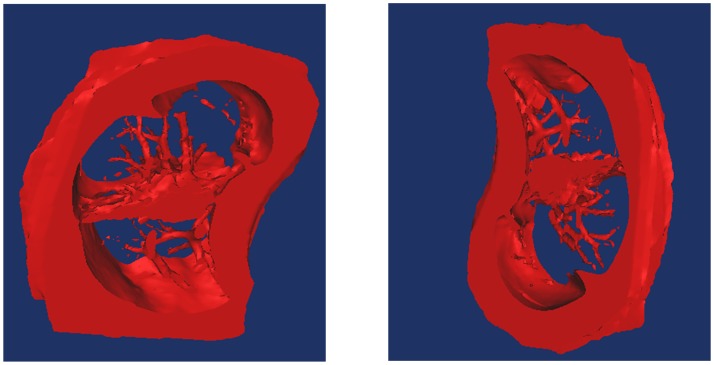
3D reconstruction of juxta-vascular nodules and surrounding non-target tissues.